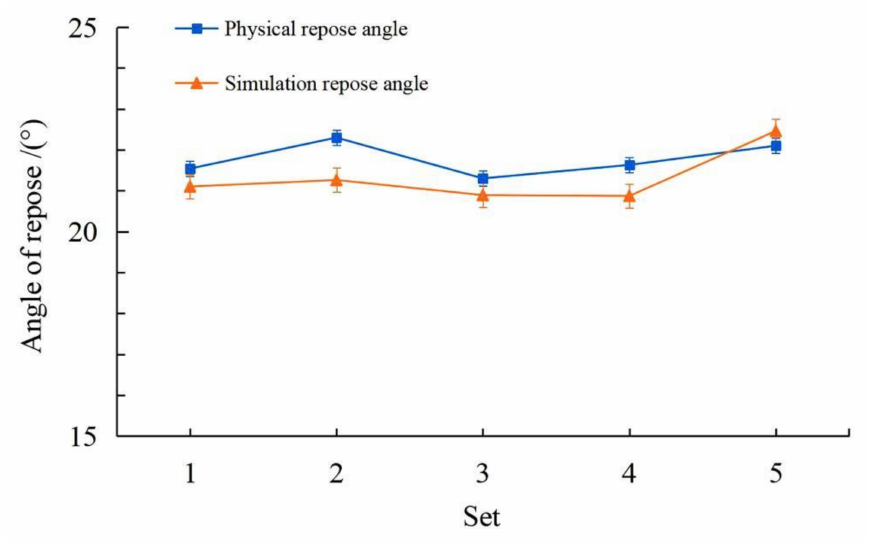
Figure 13. Comparison between the physical and the simulation value of the angle of repose under the optimal parameter combination.